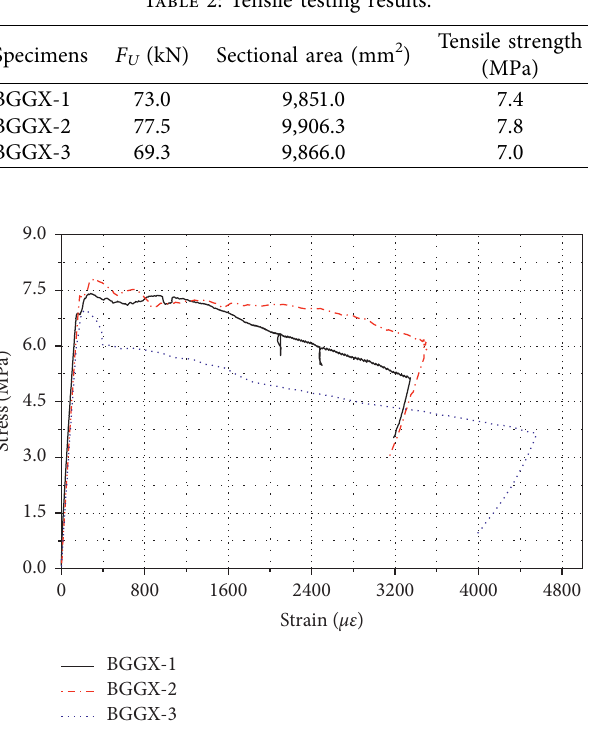
Figure 6: UHPC stress-strain